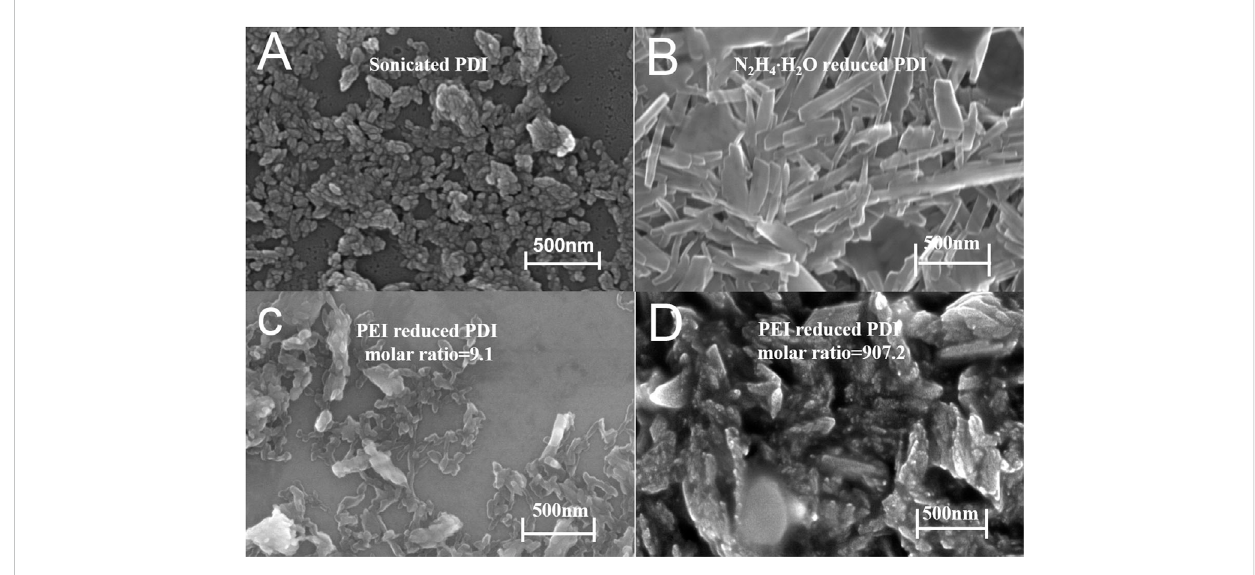
FIGURE 2 SEMimagesofsonicatedPDI (A) ;hydrazinehydratereducedPDI (B) ,andPEIreducedPDIwithamolarratioofPEIrepeatsunit/PDIequals9.1 (C) and 907.2 (D) .